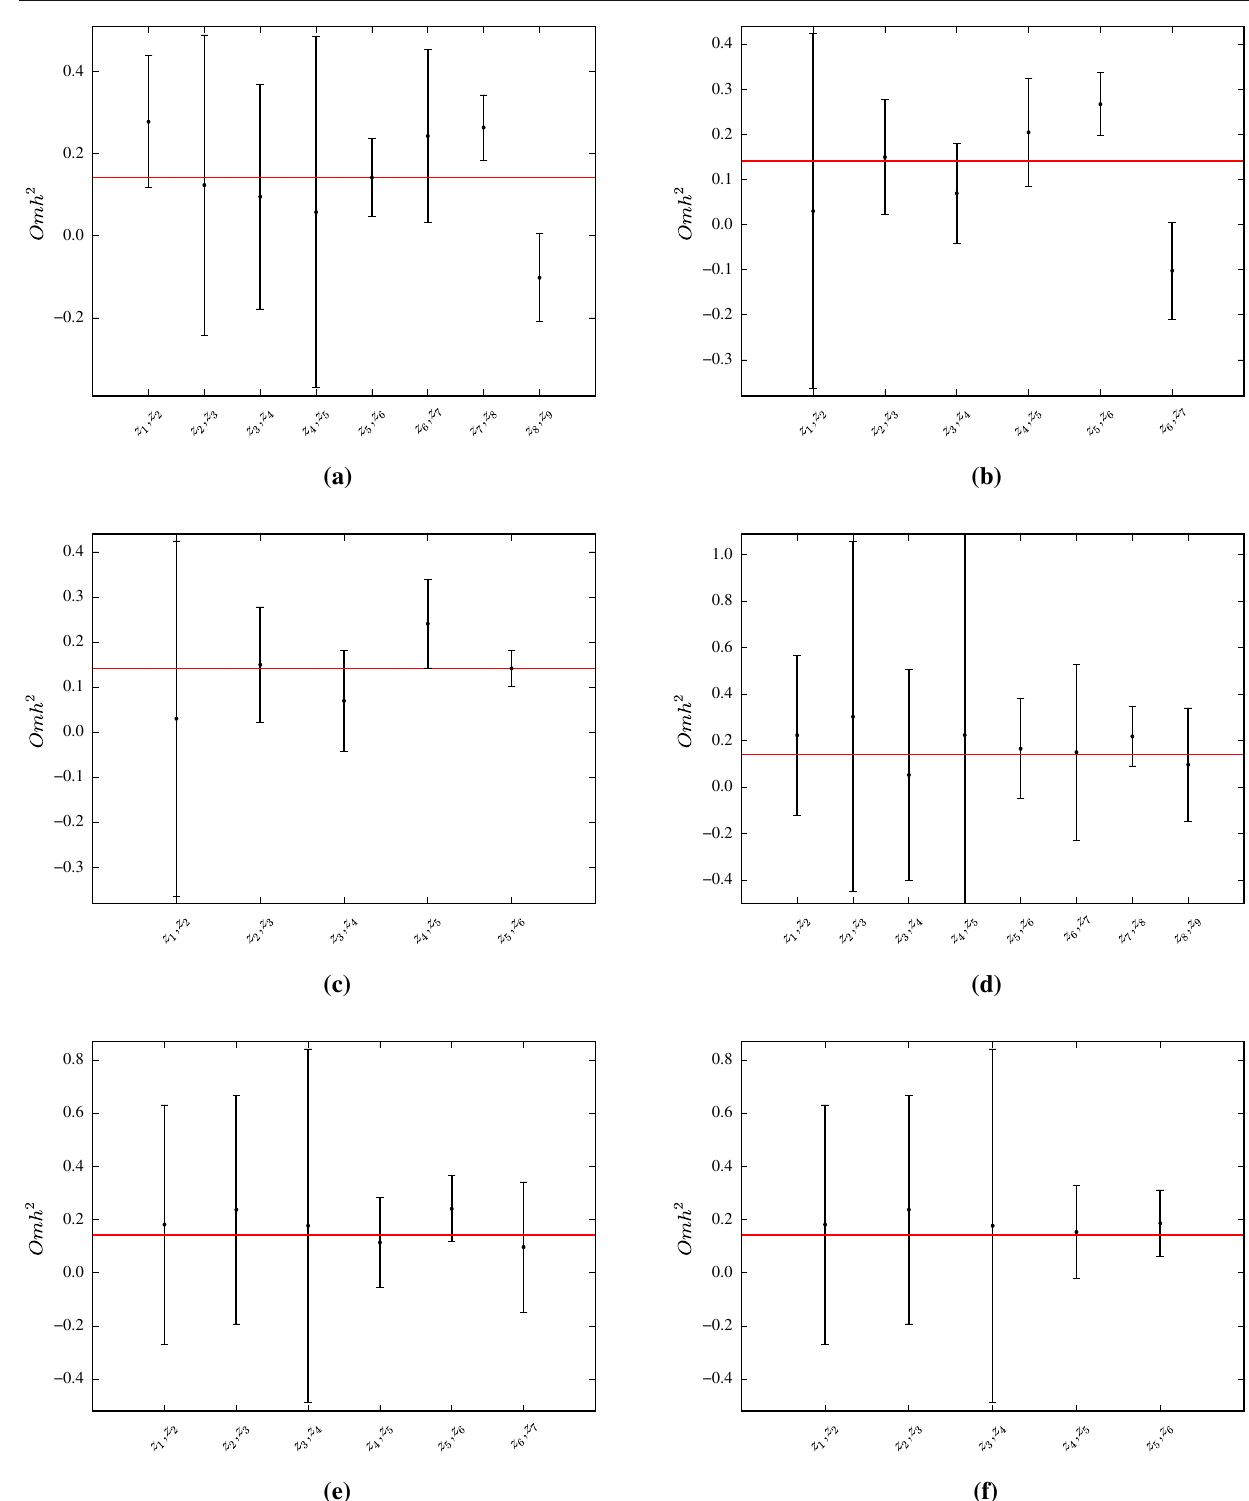
Fig. 7 Same as Fig. 4, but for OHD from the cosmic chronometer method. The panels a – c present the weighted mean 3–4, 3–4–5, and 5–6 measurements per bin, respectively, and the panels d – f present the